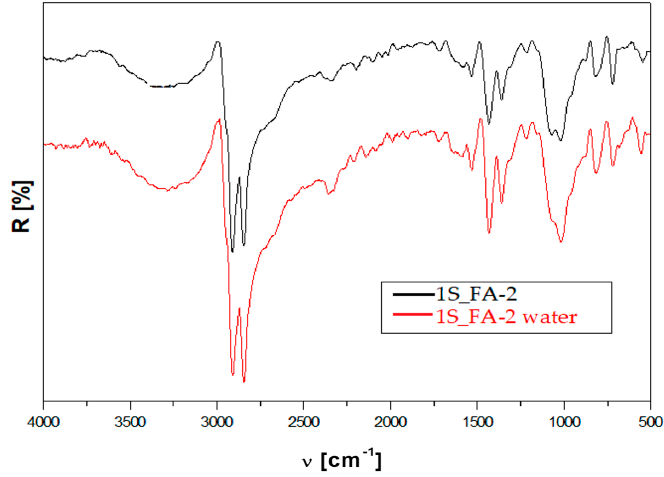
Figure 4. FTIR spectra of 1S_FA—2 before and after water immersion.